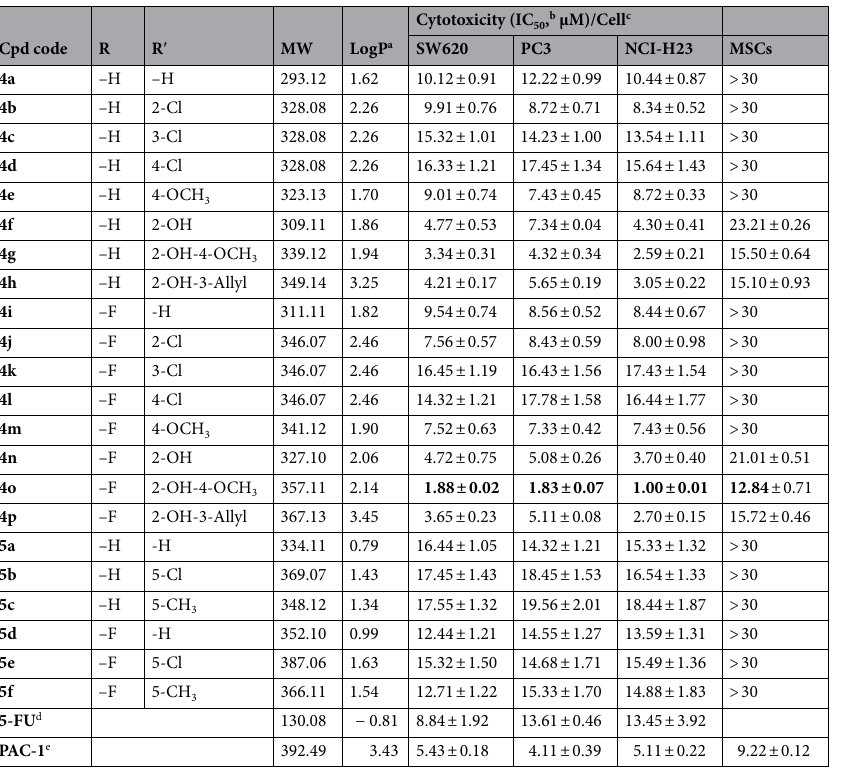
Table 1. Cytotoxicity of the selected compounds against some human cancer cell lines. Significant values are in bold. a Calculated by EPI 320 software; b The concentration (M) of compounds that produces a 50% reduction in enzyme activity or cell growth. Data represent the mean ± SEM of 3 independent experiments, each performed in triplicate.; c Cells: SW620, colon cancer; PC3, prostate cancer; NCI-H23, lung cancer; MSC, human bone marrow-derived mesenchymal stem cells; d 5-FU: 5-Fluorouracil, a positive control. Data referred from ref. 20 for relative comparison purpose; e PAC-1: the first procaspase activating compound, a positive control. Please see the Fig. 2 for the R and R ′